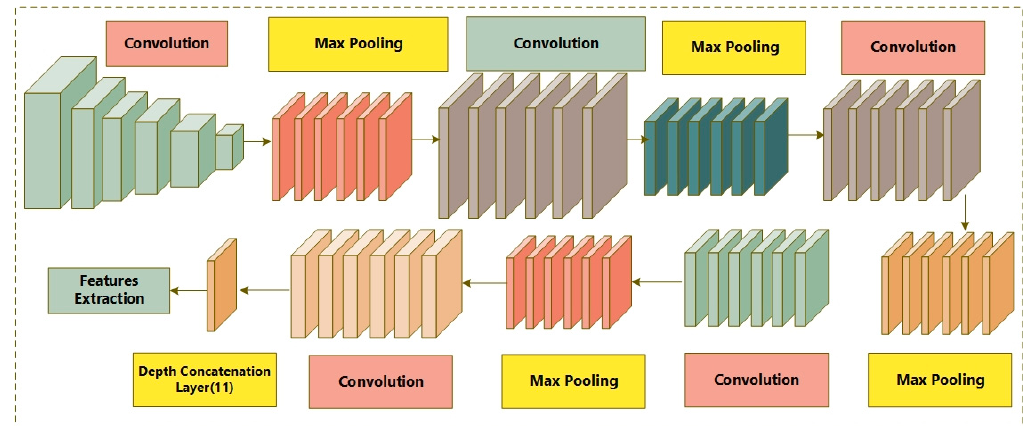
Figure 2. Architecture of Inception V3.